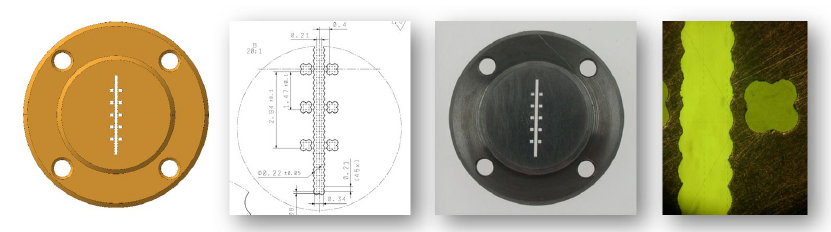
Figure 5. Original fiber plate design (CAD design, manufacturing drawing, photo, and microscopy image).